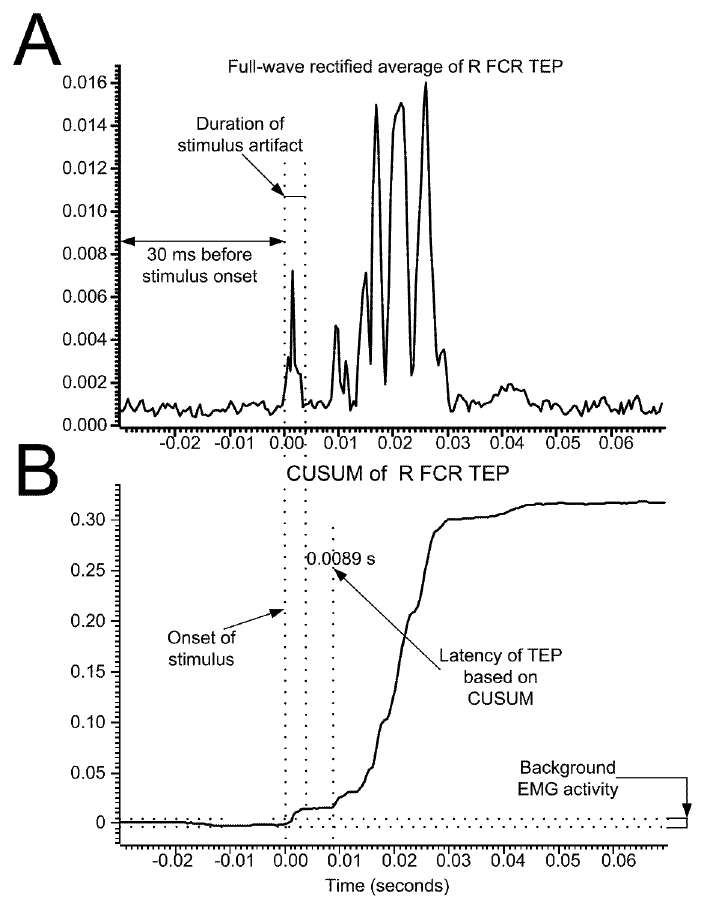
Figure 1. Latency calculation technique. Full-wave rectified waveform average ( A ) and associated cumulative sum (CUSUM) ( B ) characteristics of the TEPs ( n = 10) elicited following non-invasive cervicothoracic transpinal stimulation and recorded from the right FCR muscle using surface EMG electrodes from one subject while at rest. The CUSUM latency, which represents the TEP latency, was determined based on the turning point of the CUSUM after the stimulus artifact. doi: